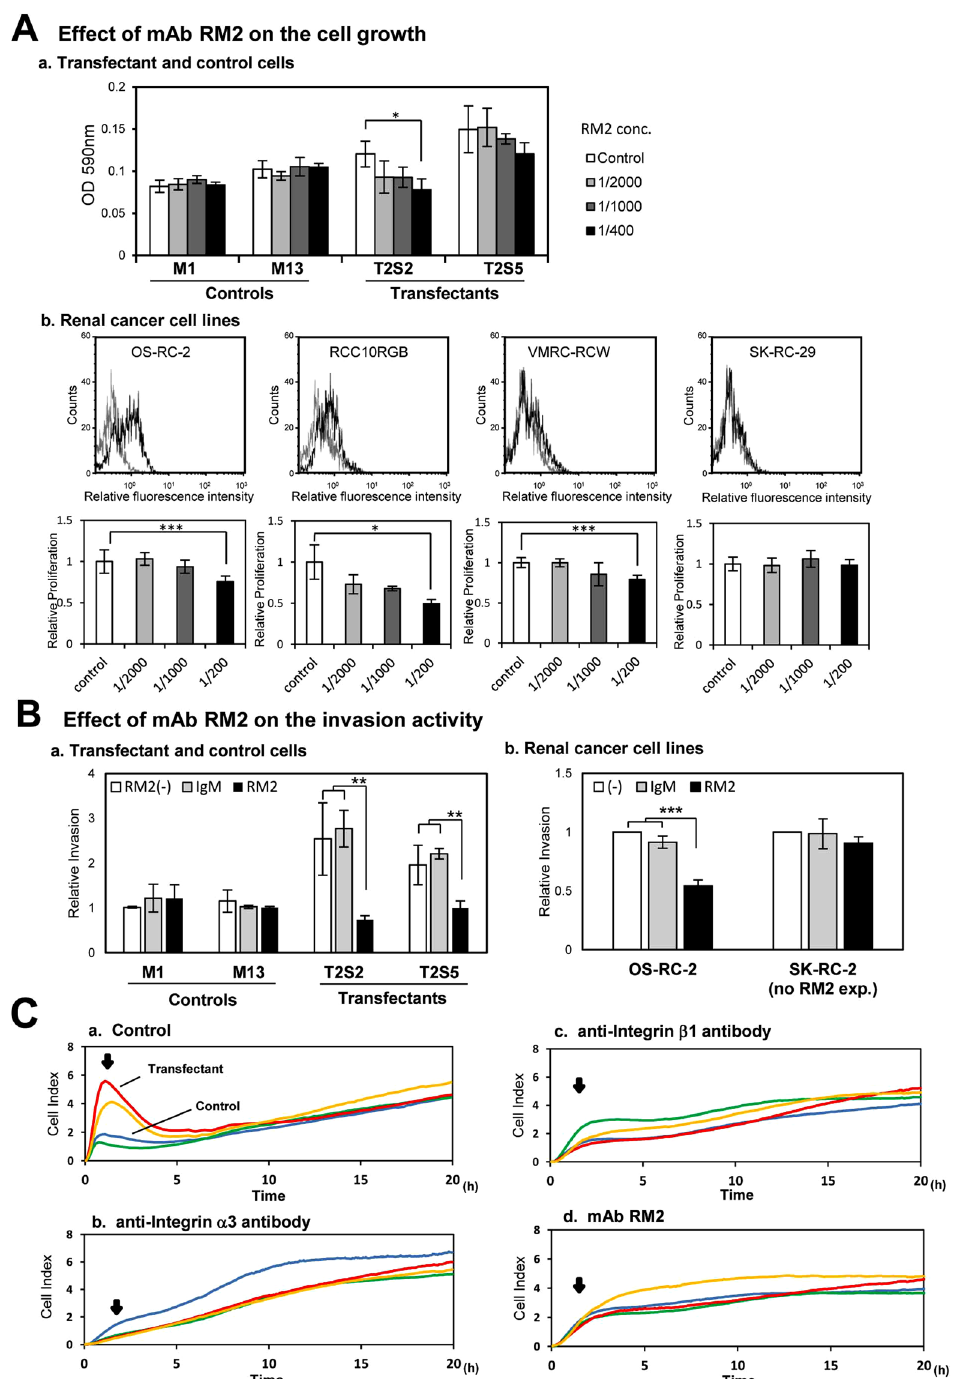
Figure 7. mAb RM2 suppressed malignant properties of the transfectant cells. ( A ) To investigate the effects of mAb RM2 on the cell growth of the transfectant cells and control cells, cells (2.5 × 10 3 cells/well) were prepared in 48-well plates in serum-containing D-MEM and cultured for 5 days with mAb RM2-containing D-MEM. MTT assay was performed as described in “Materials and Methods” ( a ). The absorbance (590 nm) was measured on day 5. Data are means of three independent experiments. In a same manner, the effects of mAb RM2 on 4 RCC lines (OS-RC-2, RCC10RGB, VMRC-RCW, and SK-RC-29) were examined ( b ). Surface expression of GalNAc-DSLc4 on these cell lines was analyzed by flow cytometry using mAb RM2, and MTT assay with mAb RM2-containing D-MEM was performed as described above. Black profiles mean GalNAc- DSLc4 expressing cells, and light gray profiles mean negative control cells in flow cytometric assay. Data of MTT assay are means of three independent experiments. ( B ) The effect of mAb RM2 on invasiveness was investigated the transfectant cells or control cells using in vitro invasion assay ( a ). In same manner, effects of mAb RM2 on 2 RCC lines (OS-RC-2 and SK-RC-29) were examined ( b ). Bars indicate mean ± S.D. (n = 3). * P <